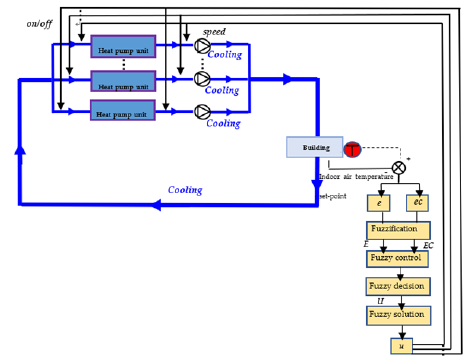
Figure 3. The logic diagram of the room temperature fuzzy (RTF) control strategy.